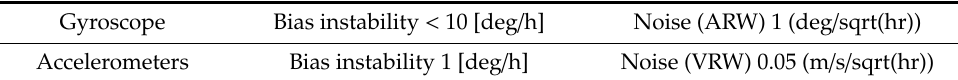
Table 1. IMU sensors specifications.